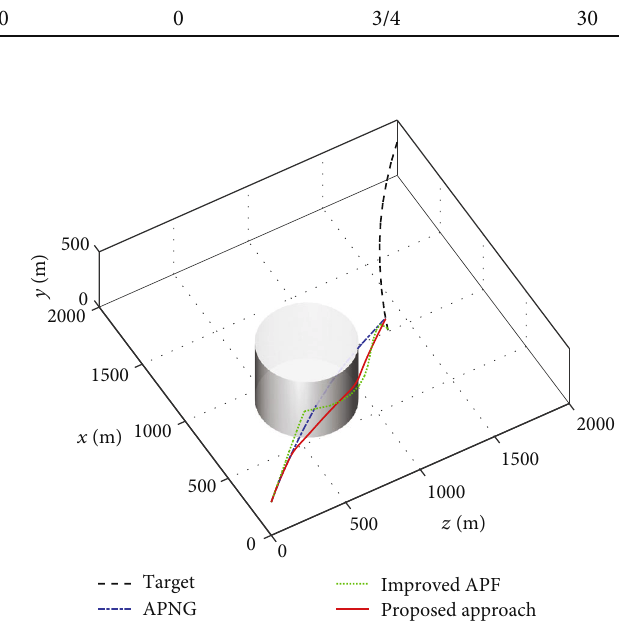
Figure 8: Flight trajectories of interceptor and target in case 1.